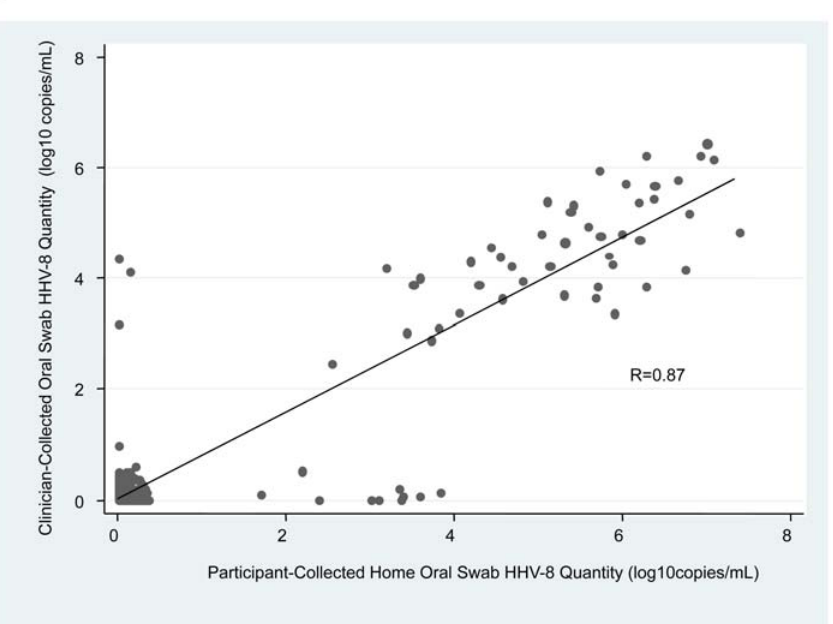
Figure 2. Correlation between HHV-8 detection in participant- and clinician- collected oral swabs. The quantity of HHV-8 DNA detected in oral swabs collected at home by participants was compared to those collected in clinic by trained clinicians. R=Spearman correlation coefficient.